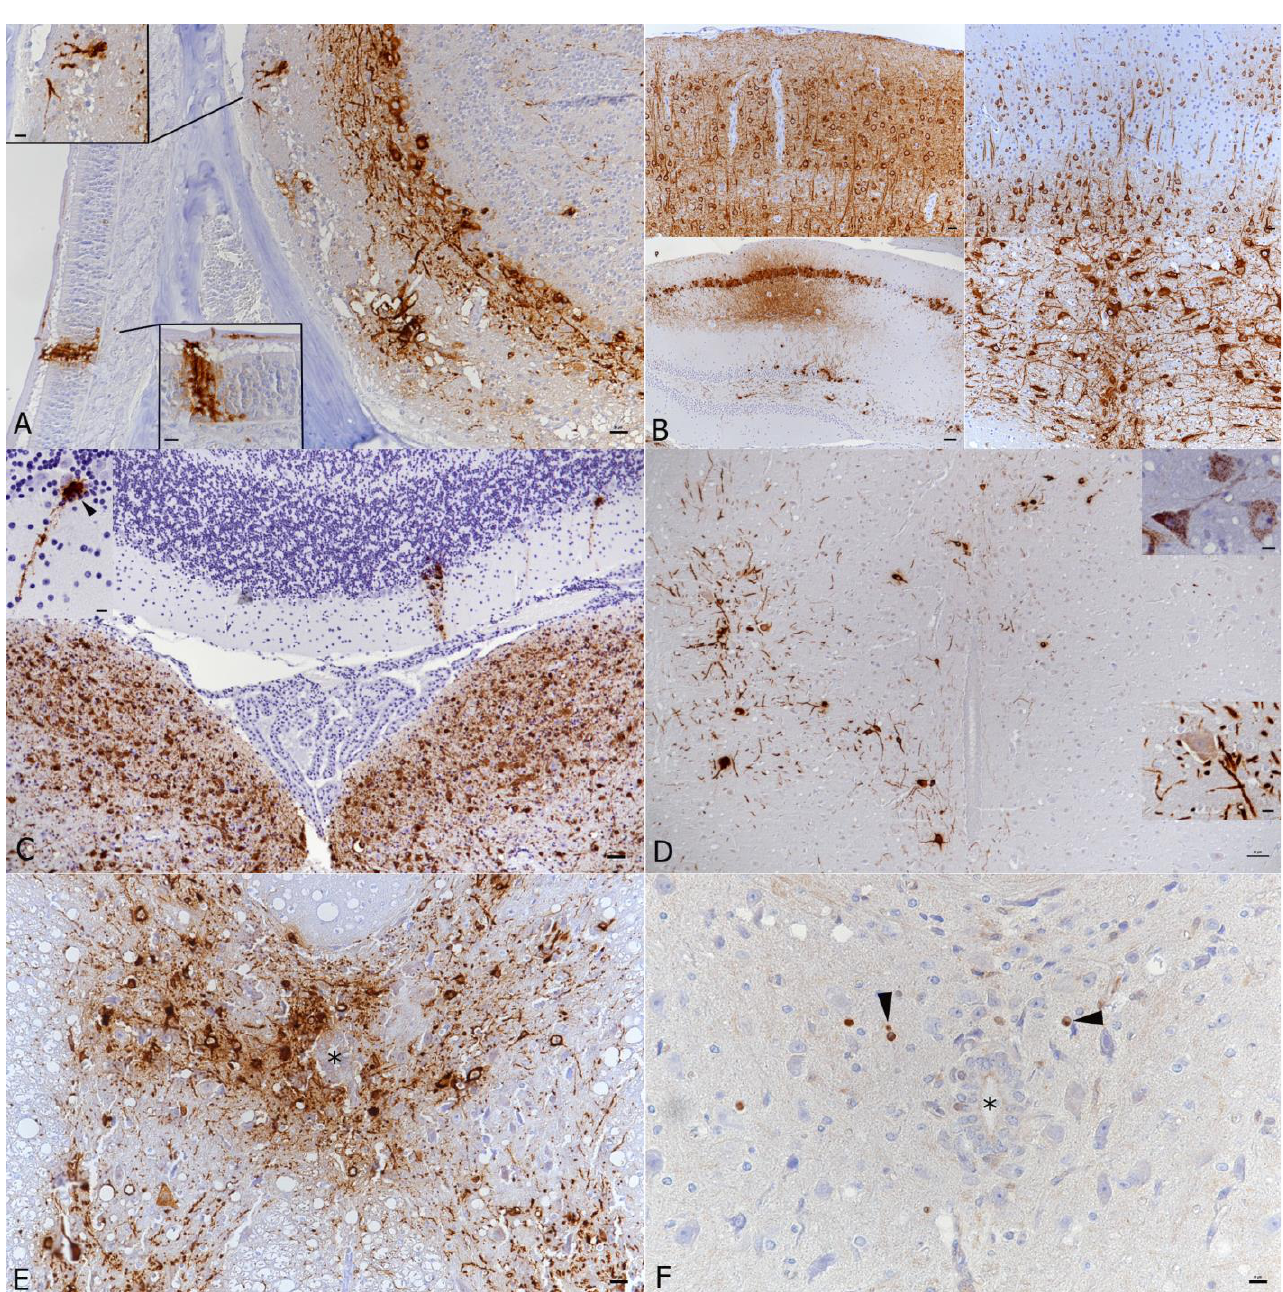
Figure 3. Brain and spinal cord, K18-hACE mice, day 7 post-intranasal SARS-CoV-2 Pango lineage B infection (10 4 PFU as single infection, or as double infection after initial infection with IAV (10 2 PFU IAV strain A/X31)). ( A ) Double infected animal, main olfactory epithelium (MOI), cribriform plate and olfactory bulb. Viral antigen is detected in olfactory neurons and basal cells of the MOI and in granule layer, inner and outer plexiform layer, mitral layer as well as glomerular layer of the olfactory bulb. Bar = 20 µm. ( B ) Double infected animal, examples of viral antigen expression in different brain regions. Top: frontal cortex with viral antigen expression in almost all neurons (left) and mid cortex with proportion of positive neurons (right); bar = 20 µm. Bottom: patchy virus anti- gen expression in the hippocampus (CA1 and CA3; left; bar = 50 µm) and strong expression in the medulla oblongata (right; bar = 20 µm). ( C ) Single infected animal, medulla oblongata and cerebel- lum. Viral RNA is abundantly expressed in neurons in the medulla oblongata (vestibular nuclei). The cerebellar cortex exhibits a few positive Purkinje cells (see also inset). Bar = 50 µm. ( D ) Single